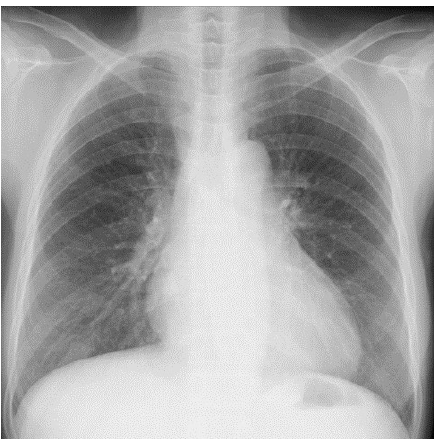
Figure 1. Chest X-ray image on admission to the previous hospital. No abnormal findings were observed.